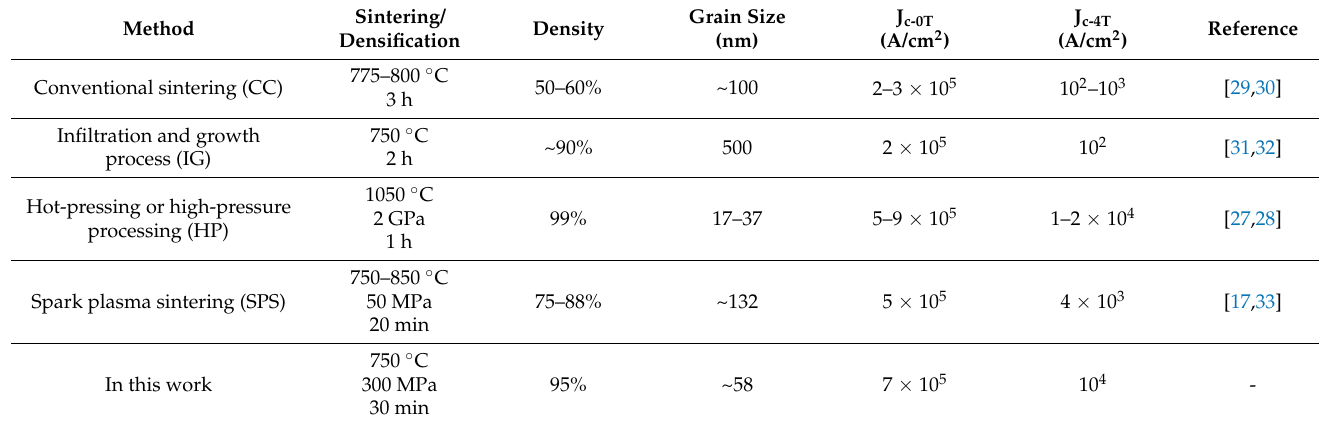
Table 1. Characterization of MgB 2 bulks prepared using different techniques.